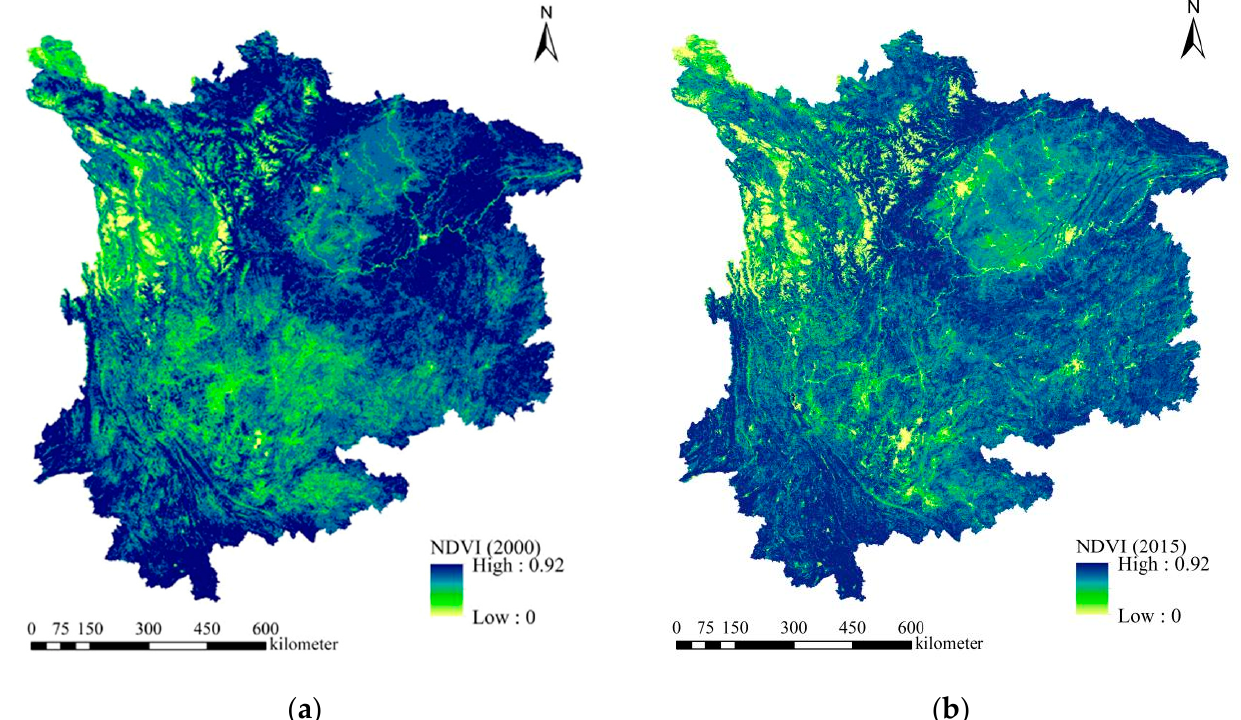
Figure 3. Spatial distribution of the NDVI in the mountainous area of southwest China in ( a ) 2000 and ( b ) 2015.